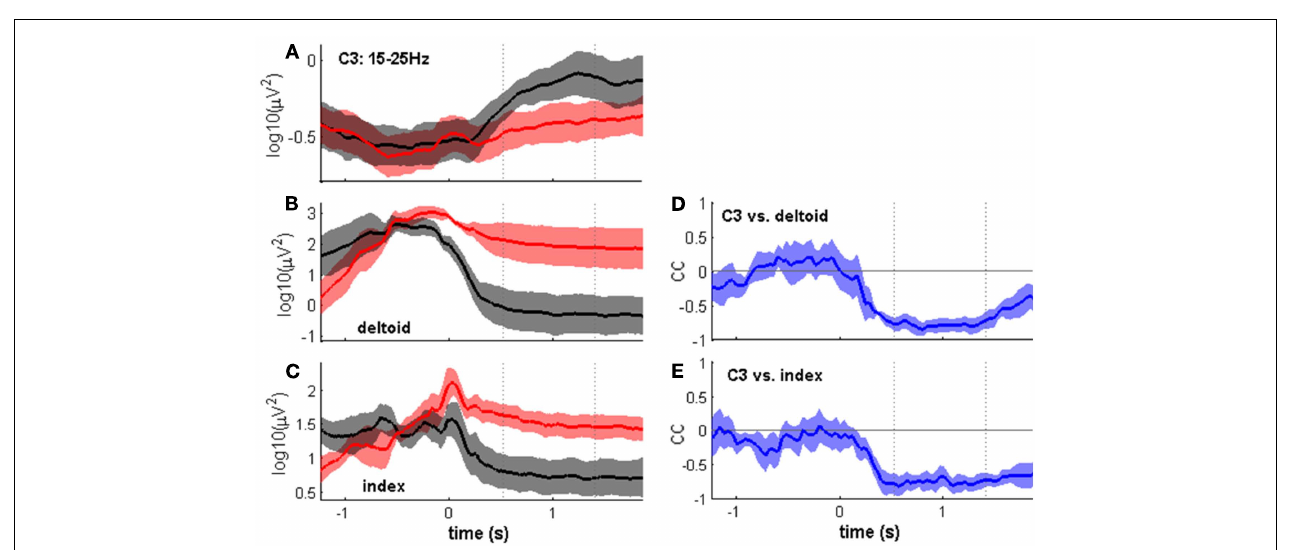
FIGURE 6 | Movement end-aligned group-averaged spectral power changes and SNR of movement class tuning. Electrode positions C3, FCZ, and C4.The only spectral component showing a robust movement class tuning across subjects was the MER2a component and is depicted with solid black boxes. Dashed black boxes represent the MER2b component. (A) Median relative spectral power changes across subjects. The scalp topography for the MER2b component is shown in (B) with its maximum at the electrode position FCZ.The scalp topography for the MER2a component is shown in (C) with its maximum at the electrode